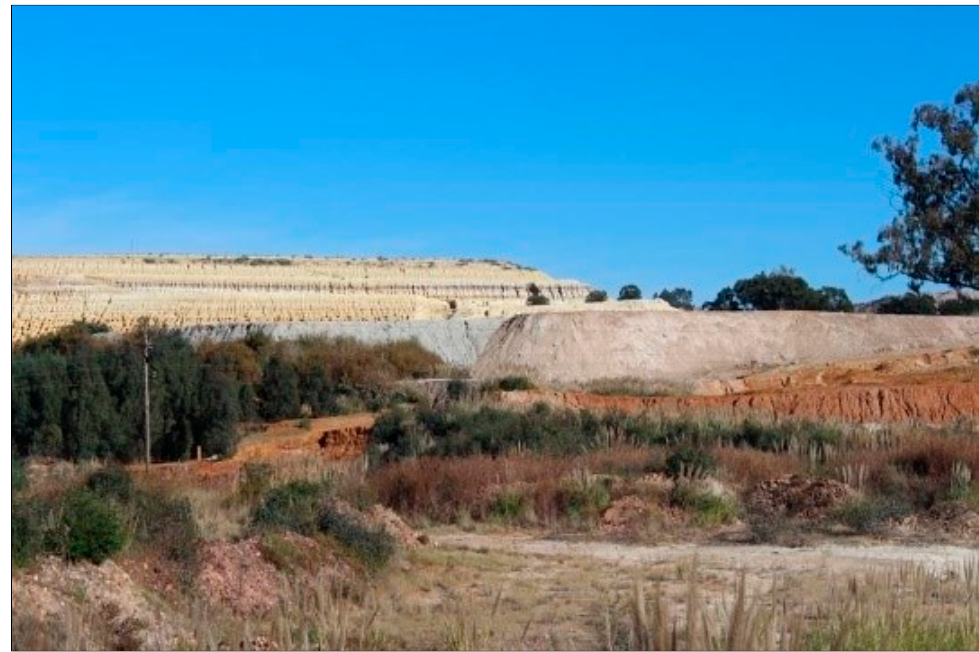
Figure 4. Tailings dam found in the study area contributing to high radon levels .